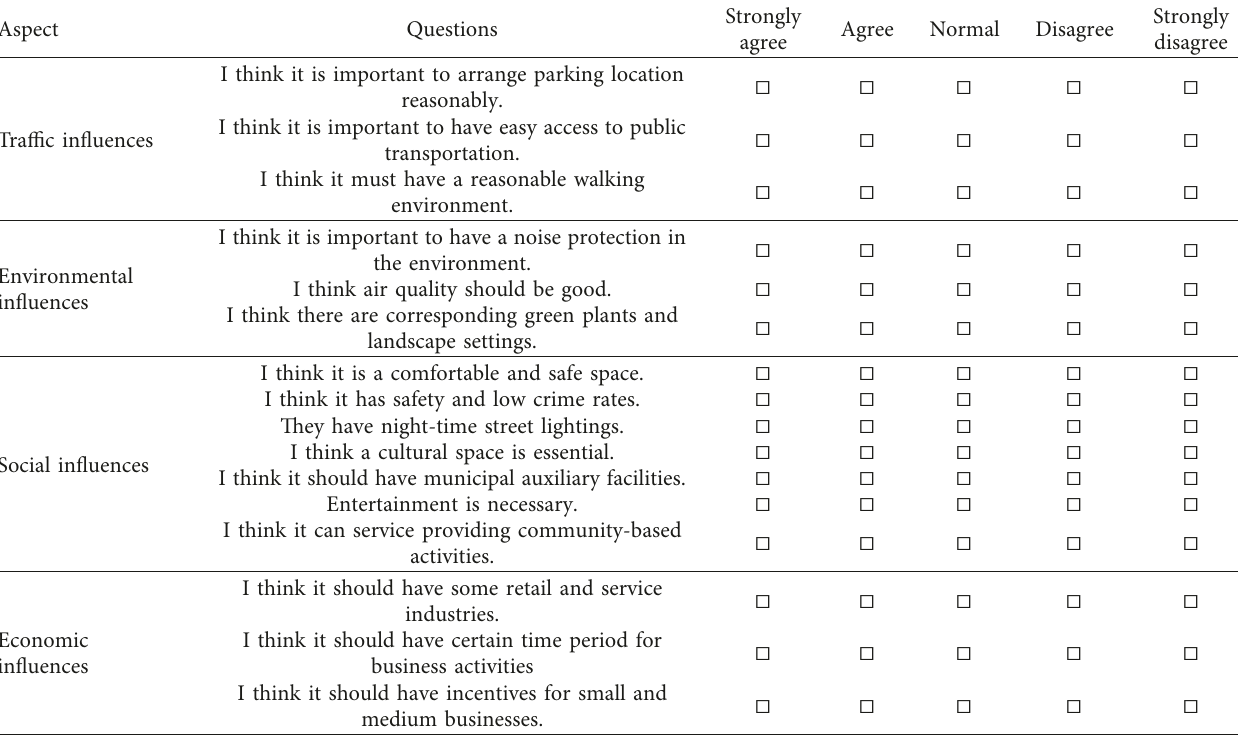
Table 1: Research